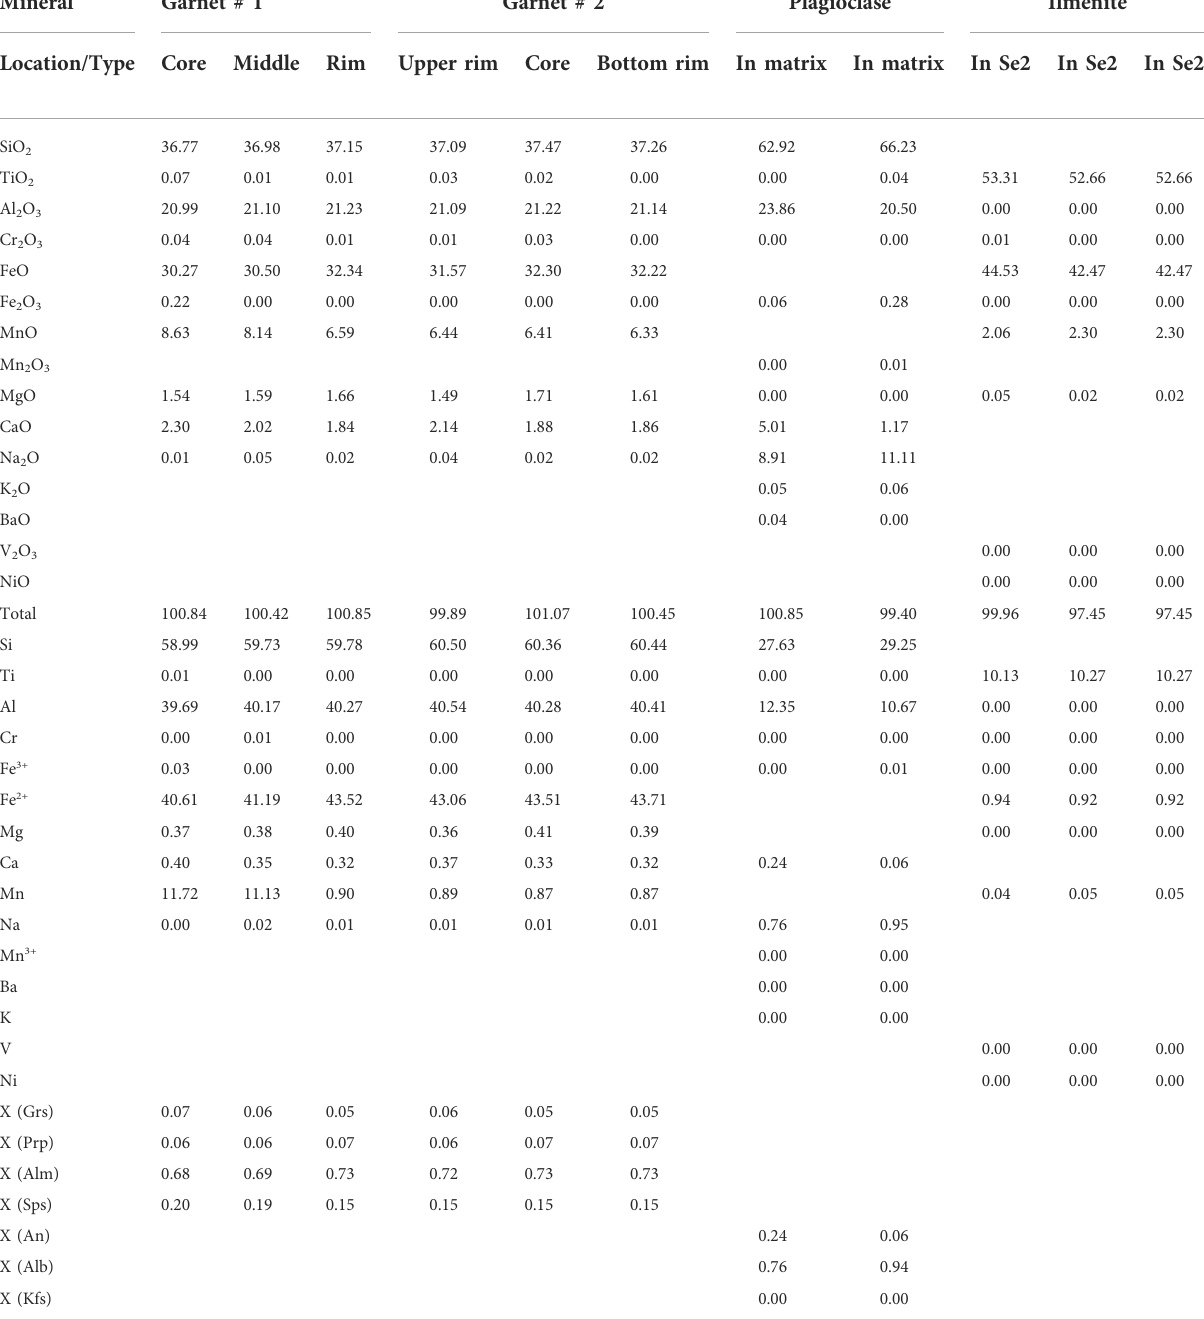
TABLE 3 Representative analyses of the garnet, plagioclase, and ilmenite from the FO1710 garnet bearing mica schist sample. Mineral Garnet #